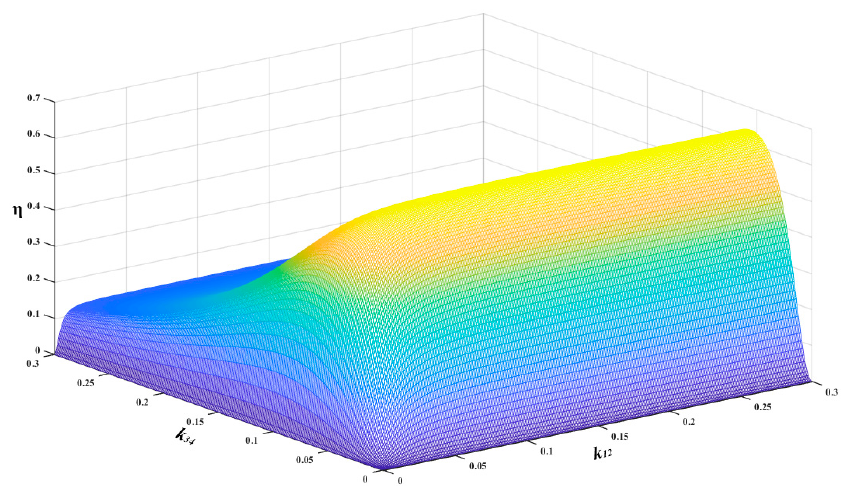
Figure 5. The efficiency as a function of the k 12 and the k 23.